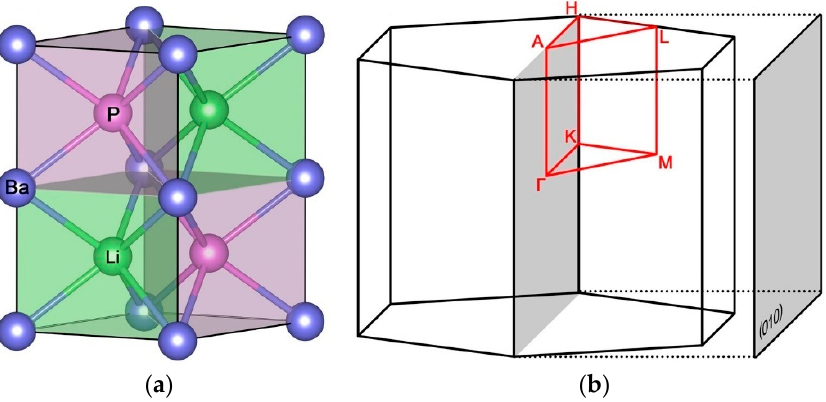
Figure 1. The unit cell ( a ) of the ternary phosphide compound BaLiP with the centrosymmetric hexagonal structure with space group P6 3 /mmc, No. 194. The spheres of various colors represent different atoms, as denoted by the text labels. Their bonding configurations form multiple polyhdera as displayed by the color shaded areas, in which the Ba atoms are allocated at the six corners and the Li and P atoms are alternately distributed at the central position. The corresponding bulk Brillouin zone ( b ) with the high symmetry points and paths, as highlighted by red color. The translucent gray color area stands for the (010) surface projection.